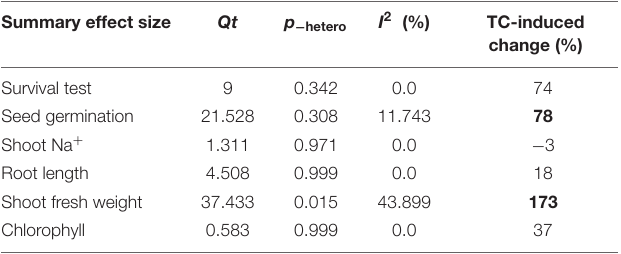
TABLE 2 | Heterogeneity statistics for the six summary effect sizes under NaCl